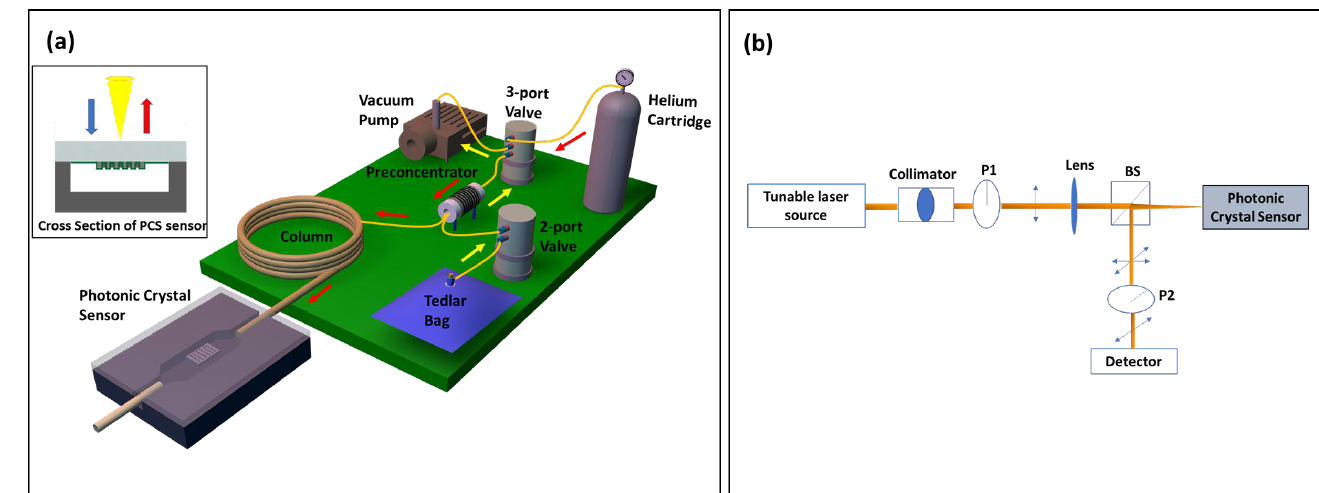
Figure 1. ( a ) Schematic of integrated µGC – PCS gas analysis system. The portable µGC system is packed into a small briefcase of 22” × 14 ” × 6.5 ” in size . The operation of µGC is controlled by a homemade LabVIEW code. The yellow (red) arrow shows the flow direction during the sampling (analyzing) stage. The PCS sensor is transfer printed to a glass substrate and then anodically bonded to a silicon microfluidic channel. The inset shows the cross-section view of the PCS sensor in a microfluidic channel. ( b ) Schematic of the optical characterization setup. BS: Beam Splitter, P1/P2: Linear Polarizer.